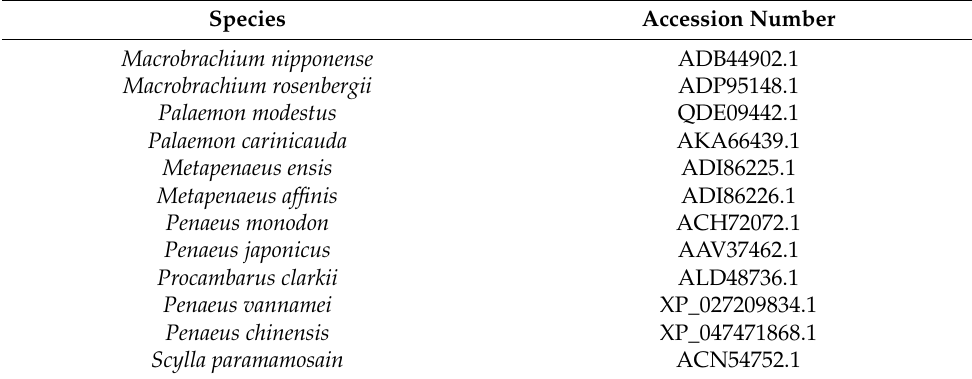
Table 2. Protein sequences of Cdc2 from different species used in this